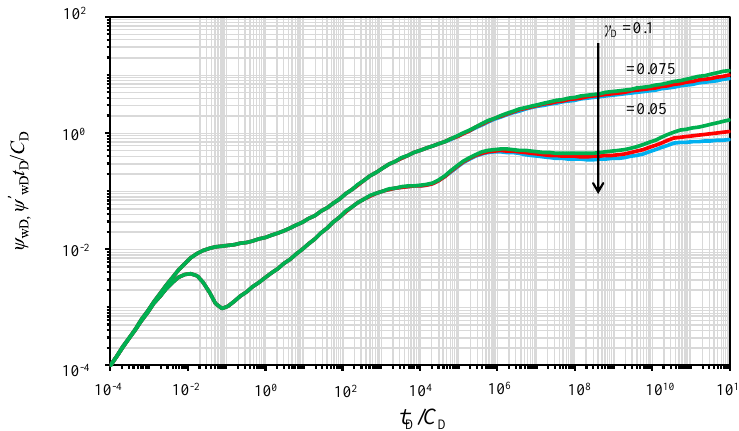
Figure 10. E ff ect of permeability modulus on the PPR and PPD. Figure 10. Effect of permeability modulus on the PPR and PPD. Figure 10. Effect of permeability modulus on the PPR and PPD.